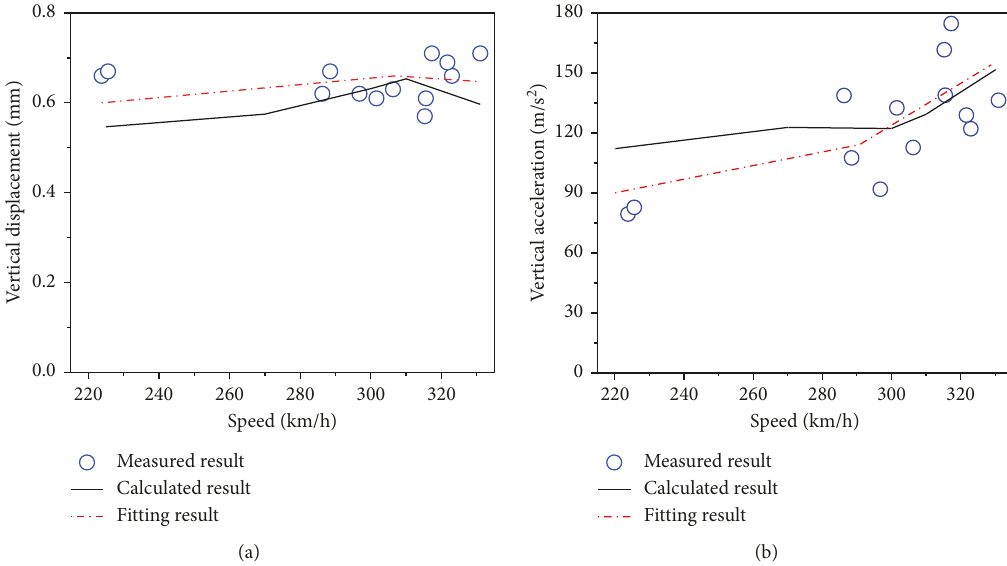
Figure 8: Comparison of measured and calculated result of rail displacement and acceleration: (a) vertical displacement; (b) vertical